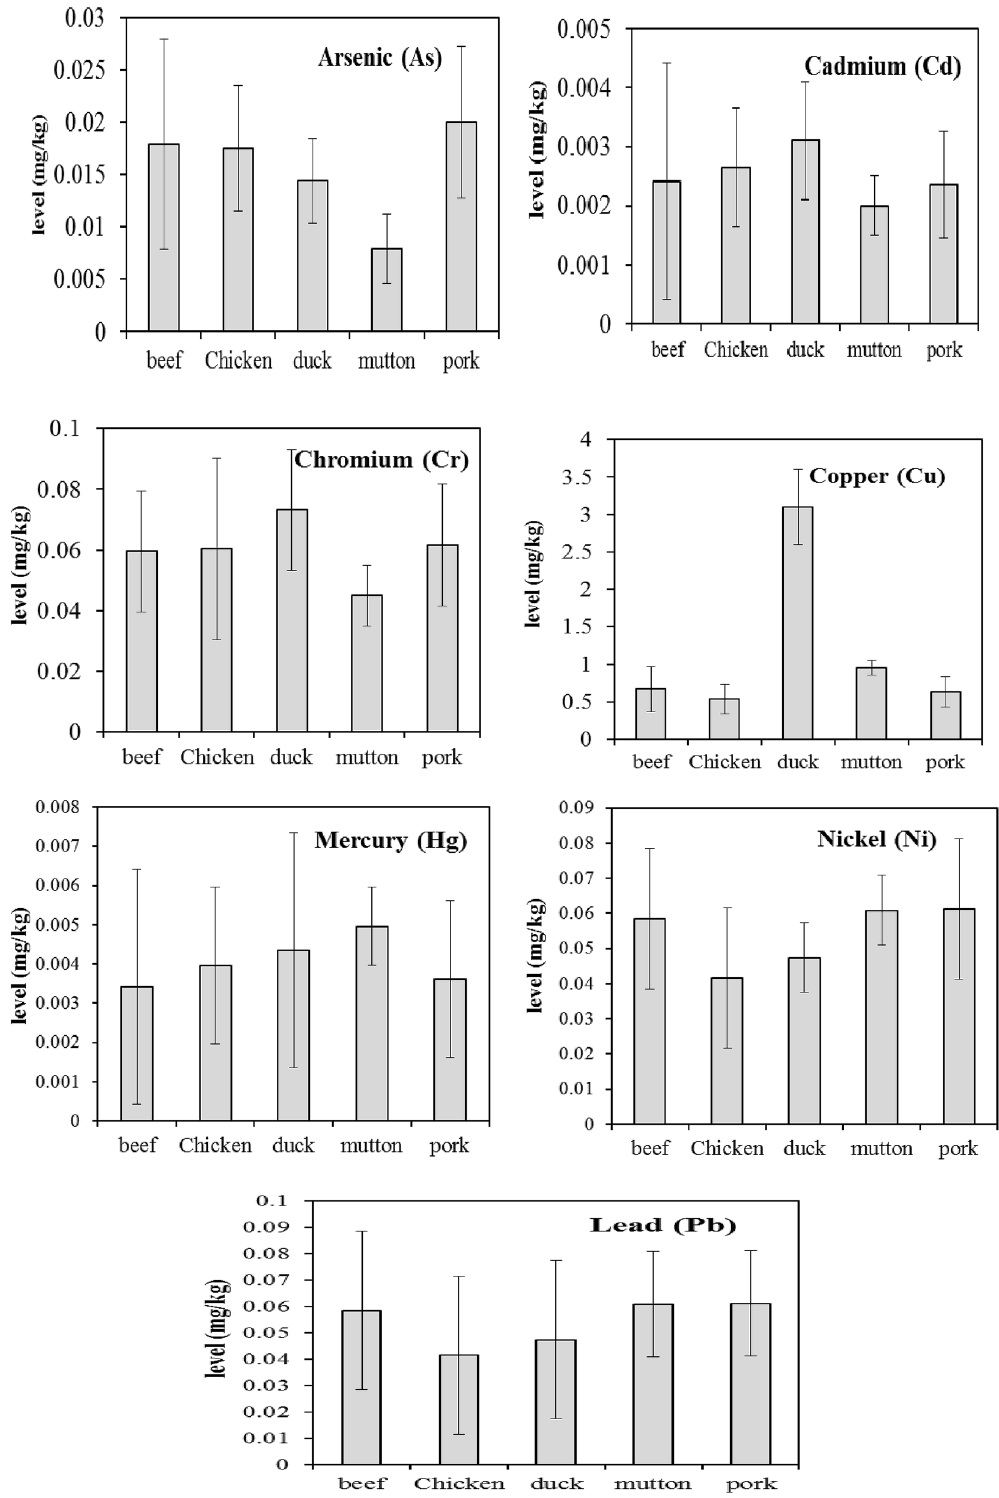
Figure 2. The levels of heavy metals (As, Cd, Cr, Cu, Hg, Ni, and Pb in different